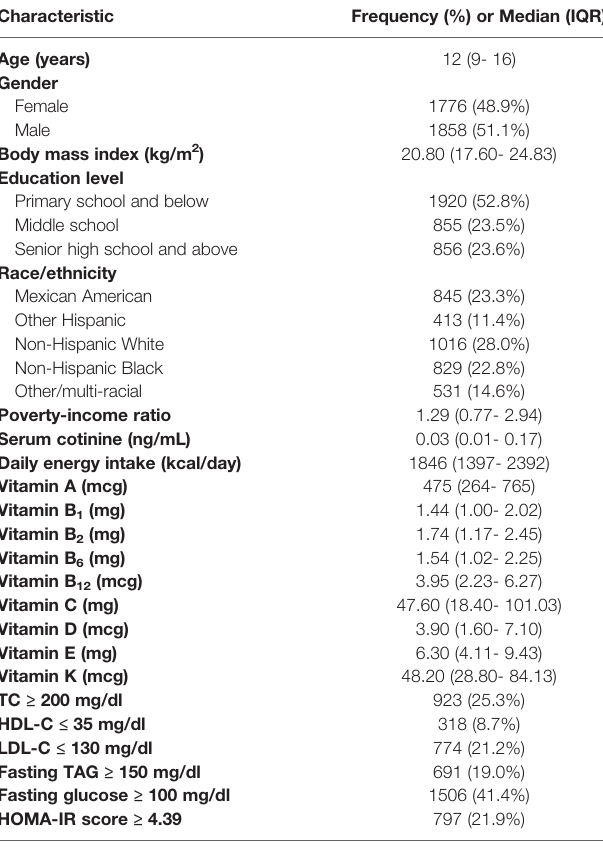
TABLE 2 | The association between each vitamin and body mass index in 3634 participants based on logistic regression model. Vitamins